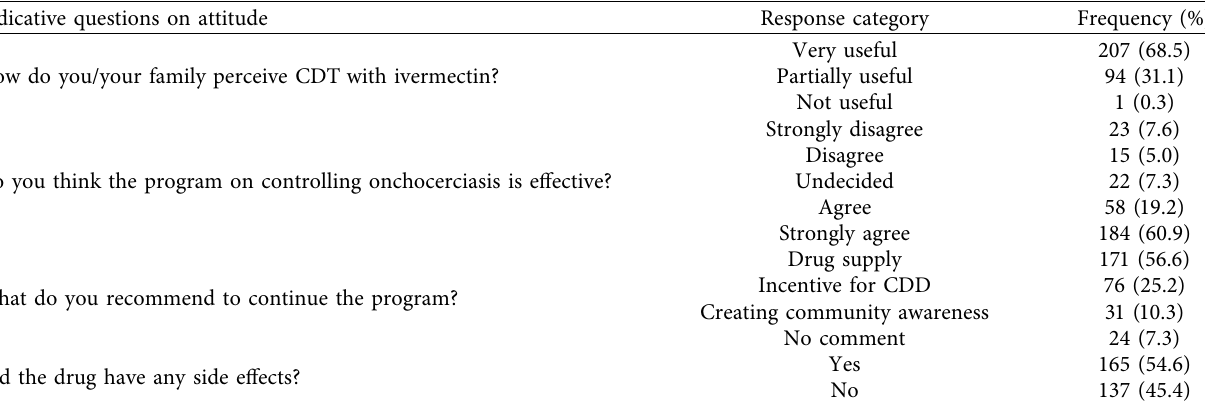
Table 4: Attitude of community respondents about onchocerciasis from Gesha town, Ethiopia.